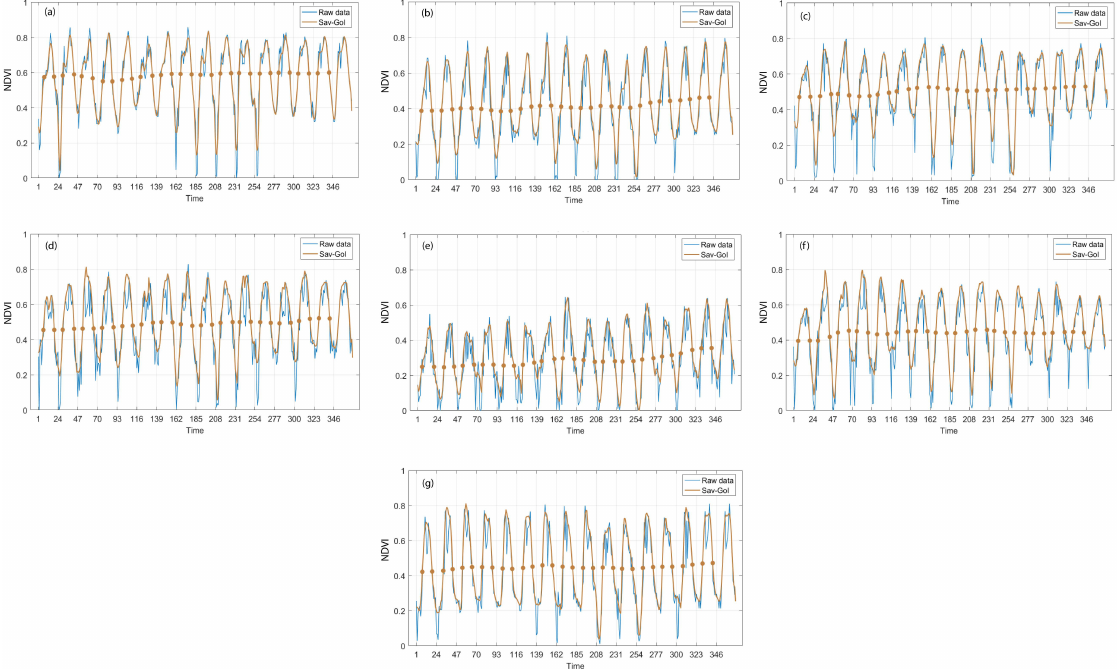
Figure 4. Seasonality time series of the selected apple orchard sites ( a ) KR1, ( b ) KR2, ( c ) KR3, ( d ) KR4, ( e ) KR-5, ( f ) KR6, and ( g ) KR7.